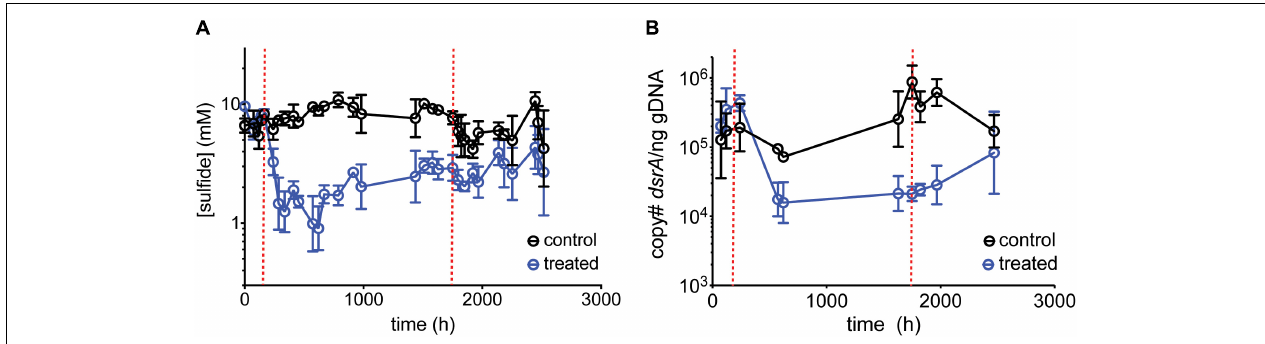
FIGURE 4 | Average (A) sulfide production, (B) dsrA copy number per ng gDNA over time for control chemostats (black circles) and chemostats treated with 50 mM perchlorate (blue circles). Dashed red lines indicate start and stop of treatment. Error bars represent SD from 3 replicates.